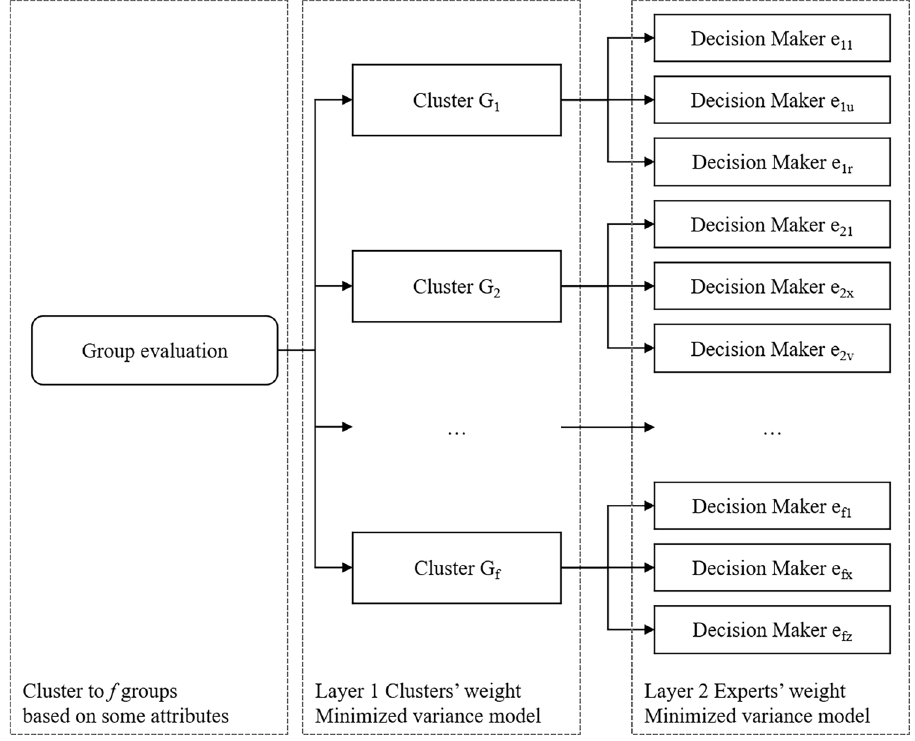
Figure 4. Two-layer expert weight determination method by Liu 40